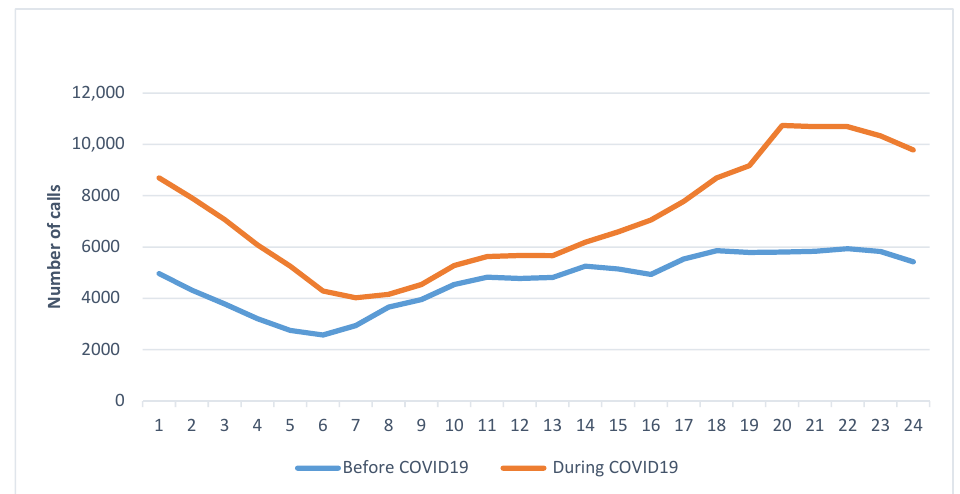
Figure 3. Comparison of the number of EMS calls per hour of the day before and during COVID-19. Before COVID-19 pandemic was defined as 1 January 2020 to 29 February 2020. “During COVID-19” was defined as 1 March 2020 to 23